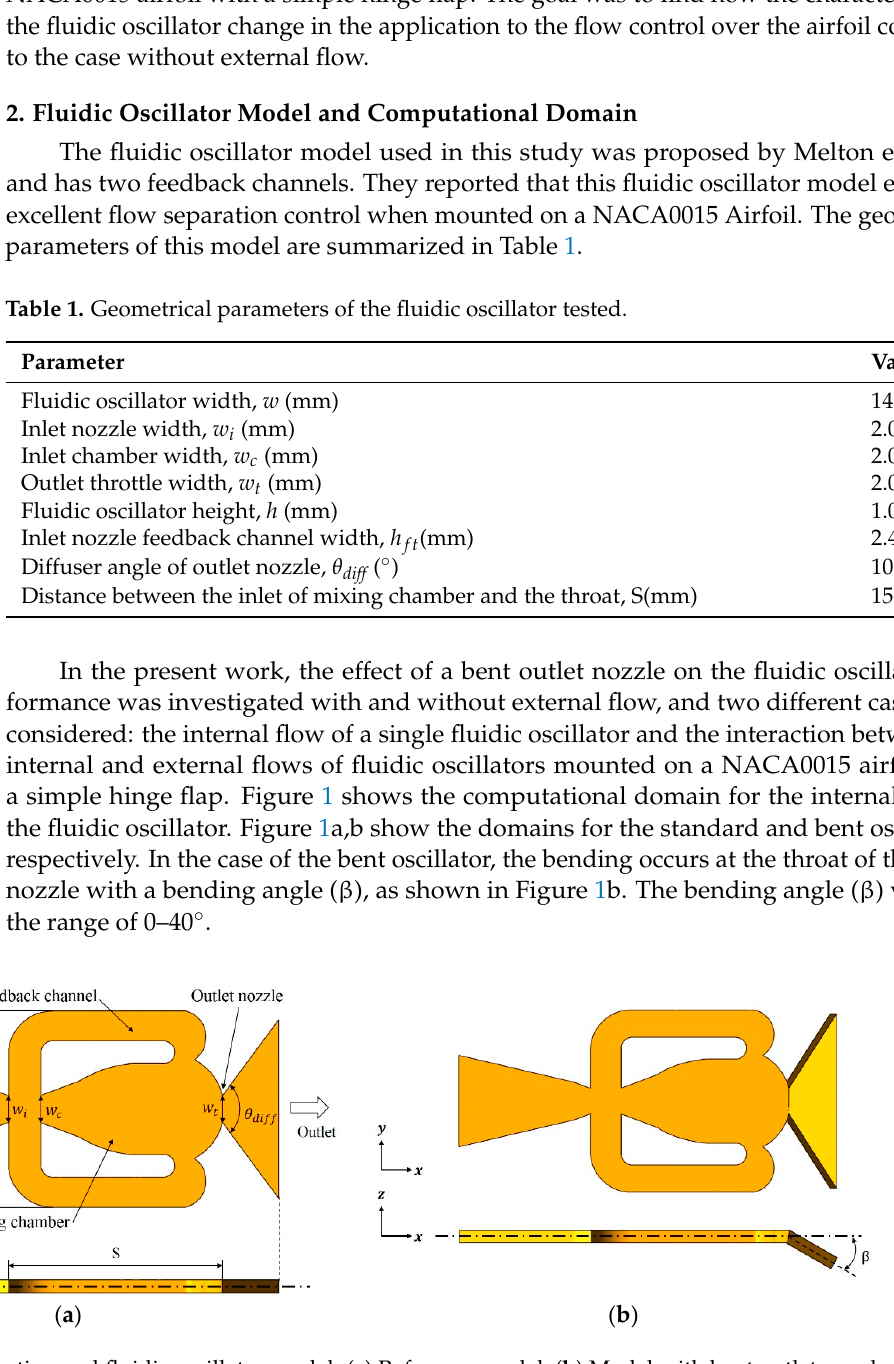
Figure 2. Computational domain for the external flow over NACA0015 airfoil with a flap and fluidic oscillators [29].